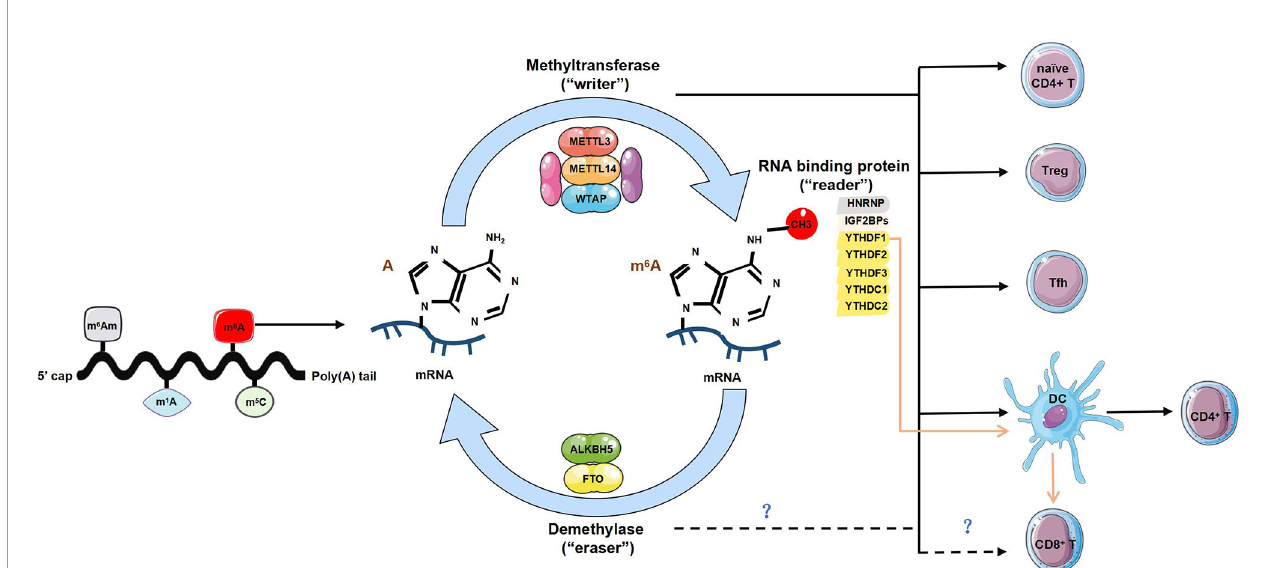
FIGURE 1 | The regulatory role of m 6 A modi fi cation in T cells. Diverse forms of RNA methylation have been identi fi ed on mRNAs, mainly involving N 6 - methyladenosine (m 6 A), N 6 -2 ’ -O-dimethyladenosine (m 6 Am), N 1 -methyladenosine (m 1 A) and 5-methylcytosine (m 5 C). m 6 A modi fi cation is reversibly installed and removed by methyltransferases ( “ writers ” ) and demethylases ( “ erasers ” ). Multiple proteins that bind to m 6 A to affect the fate of RNA are referred to as m 6 A-binding proteins ( ‘‘ readers ’’ ). The “ writers ” complex is mainly composed of METTL13, METTL14 and WTAP, can directly modulate T cells by maintaining homeostasis of naïve CD4 + T cells, promoting the function of regulatory T cells (Tregs) and T follicular helper (Tfh) cells. It also indirectly enhances CD4 + T cells function via promoting dendritic cell (DCs) activation and DC-based T cell response. The “ readers ” involve YTHDF1-3, YTHDC1-2, HNRNP and IGF2BPs. The lack of YTHDF1 can enhance antigen-speci fi c CD8 + T cell antitumor response indirectly by the increased cross-priming of CD8 + T cells by DCs. However, whether the “ writers ” and “ readers ” directly regulates the development and function of CD8 + T cells is unknown. The current identi fi ed two ‘‘ erasers ’’ are FTO and ALKBH5, whether and how “ erasers ” control T cell homeostasis or functionality is yet to be